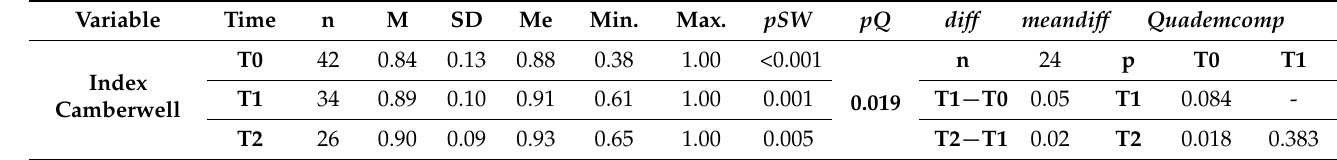
Table 3. The level of satisfaction of needs in the G2 physical activity group during T0, T1, T2.